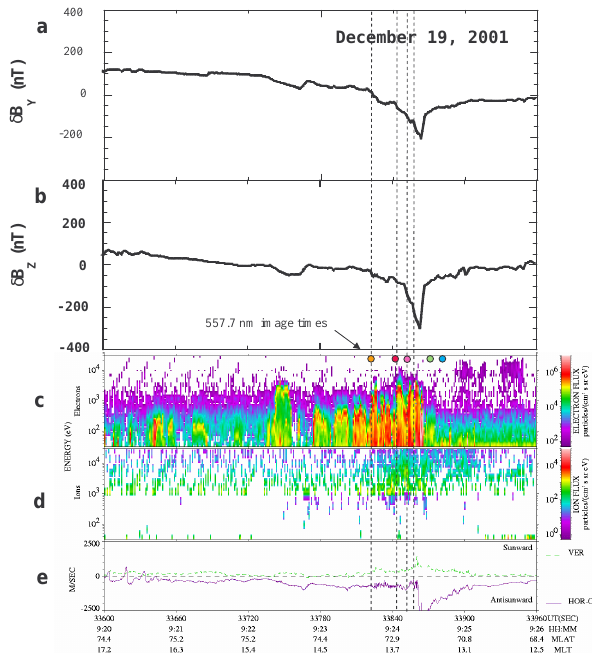
Fig. 14. High resolution DMSP F15 data showing two components of the perturbation magnetic field, electron and ion spectrograms, and the vertical and horizontal drifts. The negative slope of the per- turbation magnetic fields indicates upward Region 1 currents. The colored circles denote the central times of 557.7-nm images pre- sented in Fig. 15. Note that the first three correspond to electron en- hancements, as well as intensification in the field-aligned currents (steeper slope) from the magnetometer records denoted by the ver- tical dashed